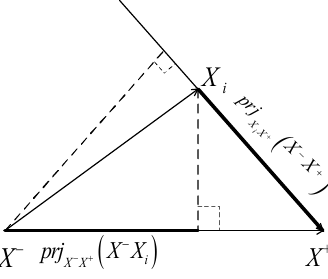
(cid:1) (cid:0) X − X + i X +